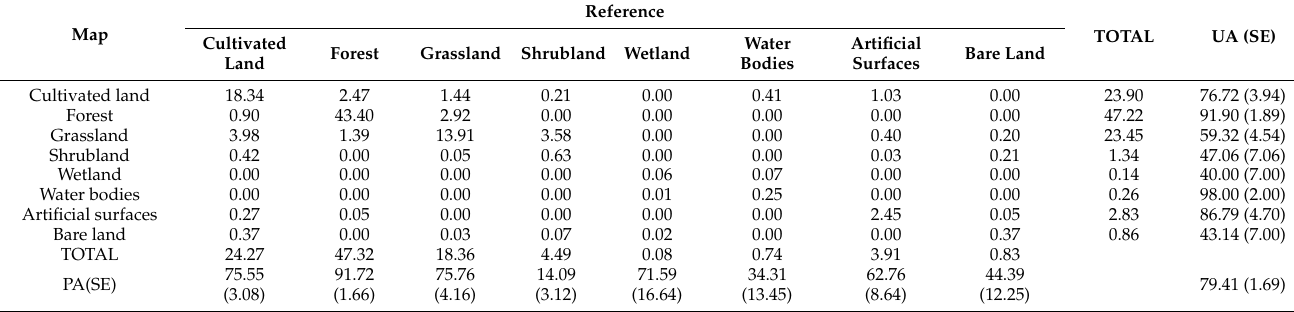
Table A6. Error matrix of GLC_FCS